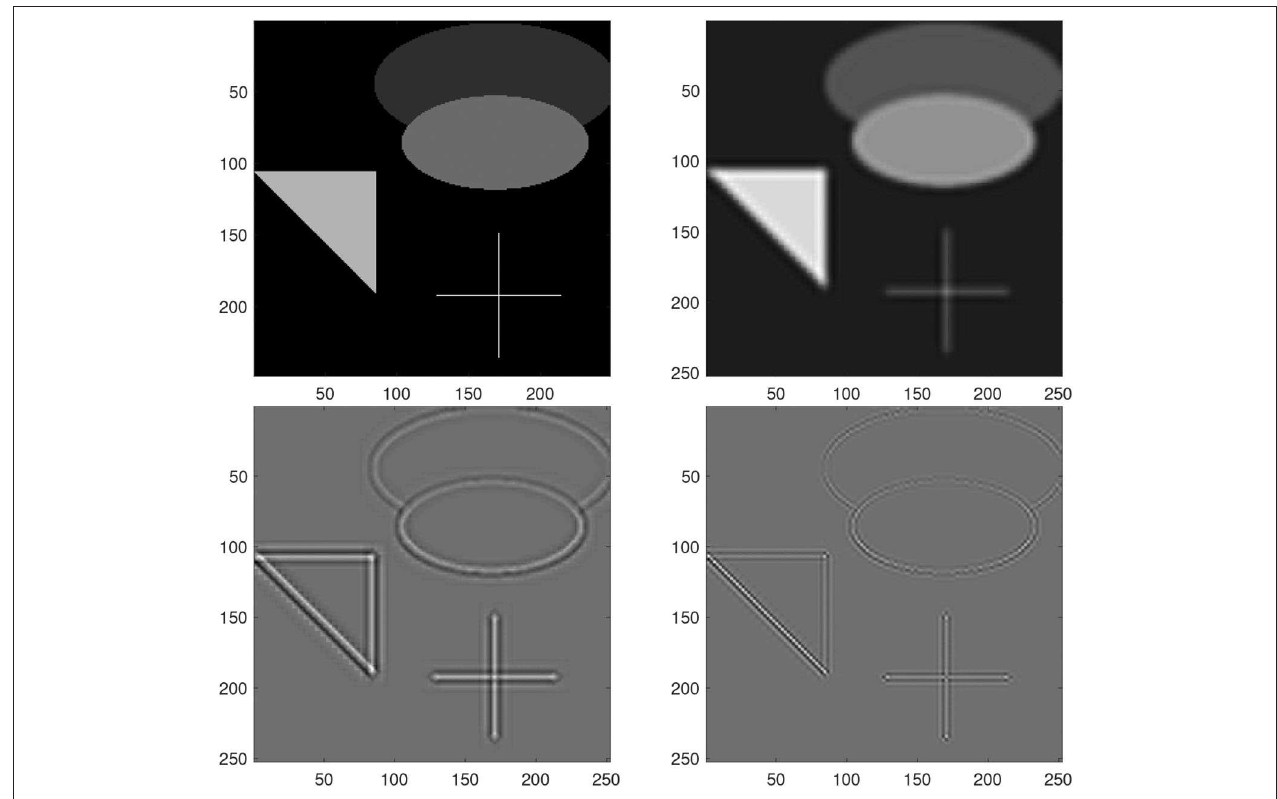
FIGURE 4 | Decomposition of components for the grayscale test image. From top to bottom and left to right: the original, T h D , K h C , 9 h E .